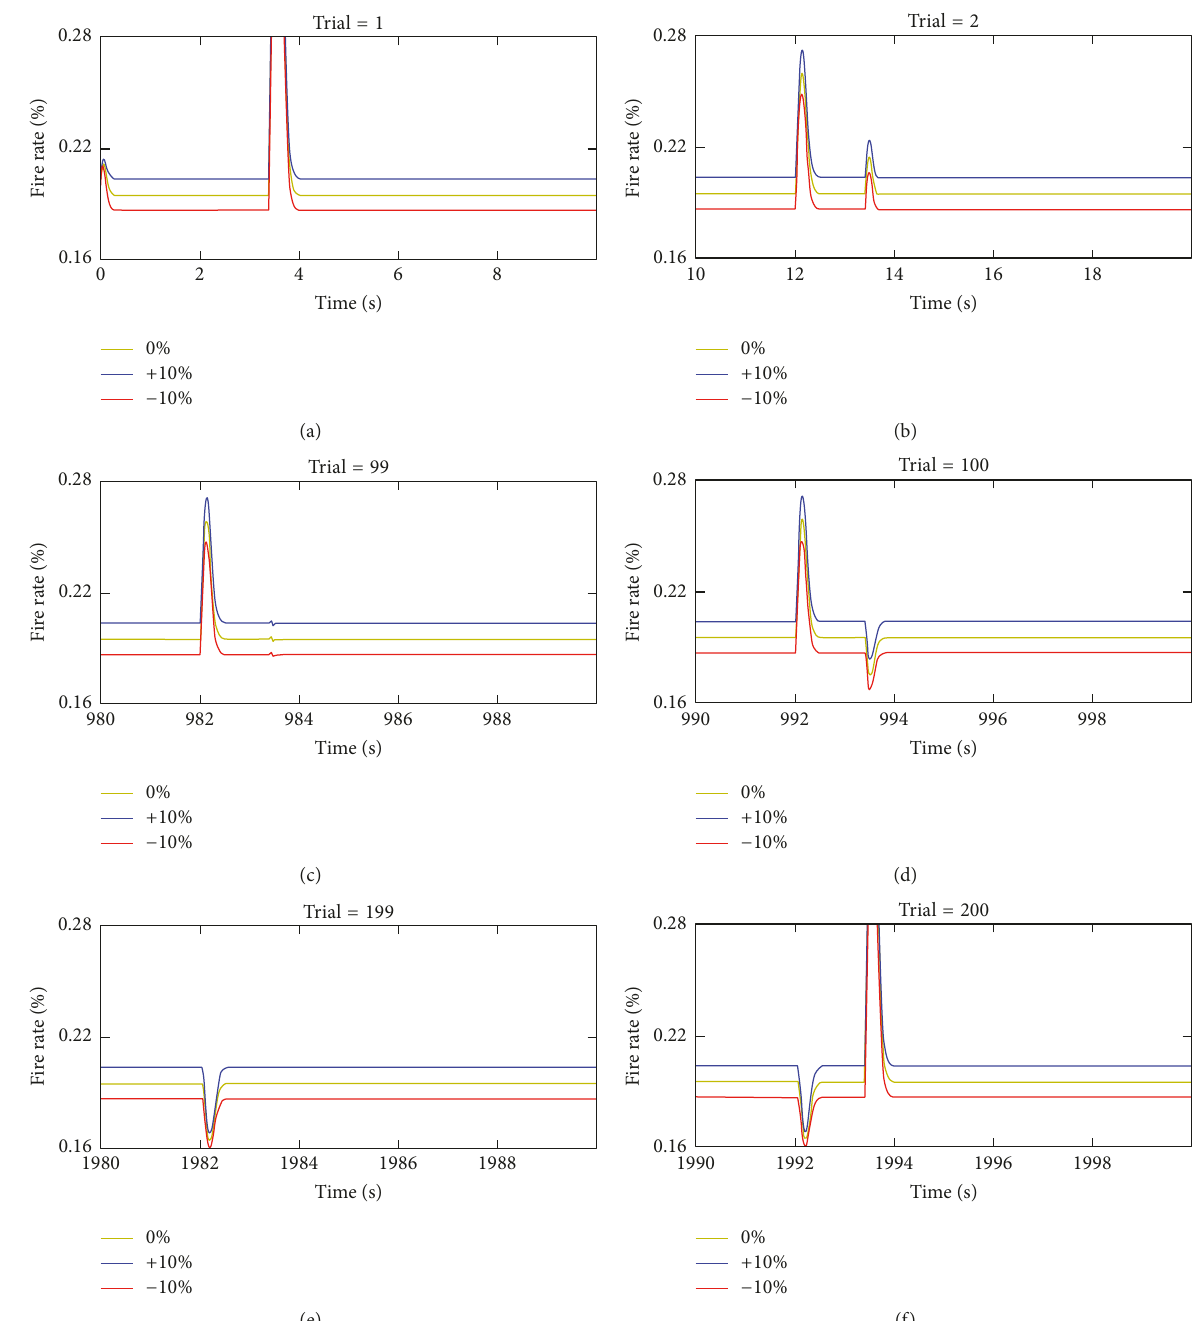
Figure 9: The phasic activity of DA neurons given different weights of synapses from VP to GPb. Yellow lines indicate the activity of DA neurons when 𝑊 equals 1.00 and 𝐷 equals 0.19431, blue lines indicate the activity when 𝑊 equals 1.10 and 𝐷 equals 0.20307, and red lines VPG VPG indicate the activity when 𝑊 equals 0.90 and 𝐷 equals 0.18608. (a) Trial 1: phasic peak activity responds to unconditional reward. (b) Trial VPG 2: the phasic activity shifts to the cue. (c) Trial 99: the phasic activity upon the cue and baseline activity upon the reward. (d) Trial 100: the dip activity upon reward omission. (e) Trial 199: the dip activity upon nonrewarding cue. (f) Trial 200: the peak activity upon unexpected reward.